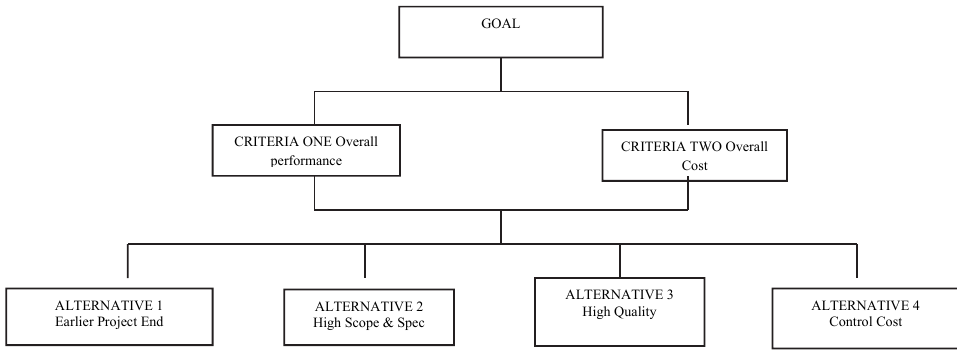
Fig. 2. Hierarchy Structure Model of Strategy